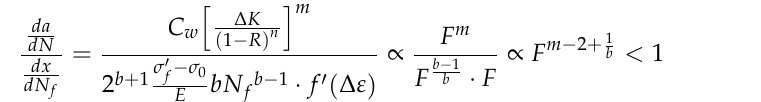
(cid:3031)(cid:3051) (cid:3031)(cid:3028) and . (cid:3031)(cid:3015) (cid:3281) (cid:3031)(cid:3015)